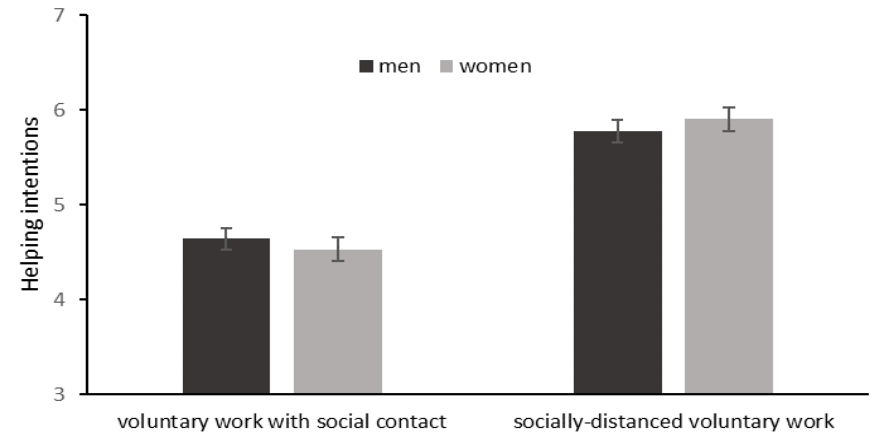
Figure 2. The effect of gender on helping intentions toward different types of voluntary work. Note. Error bars represent 95% confidence intervals.